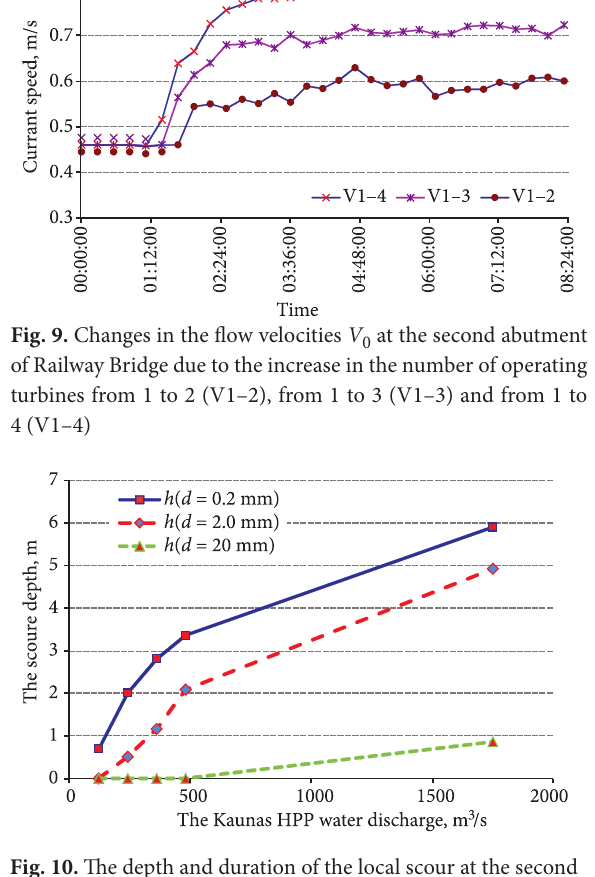
Fig. 10. The depth and duration of the local scour at the second abutment of Railway Bridge before